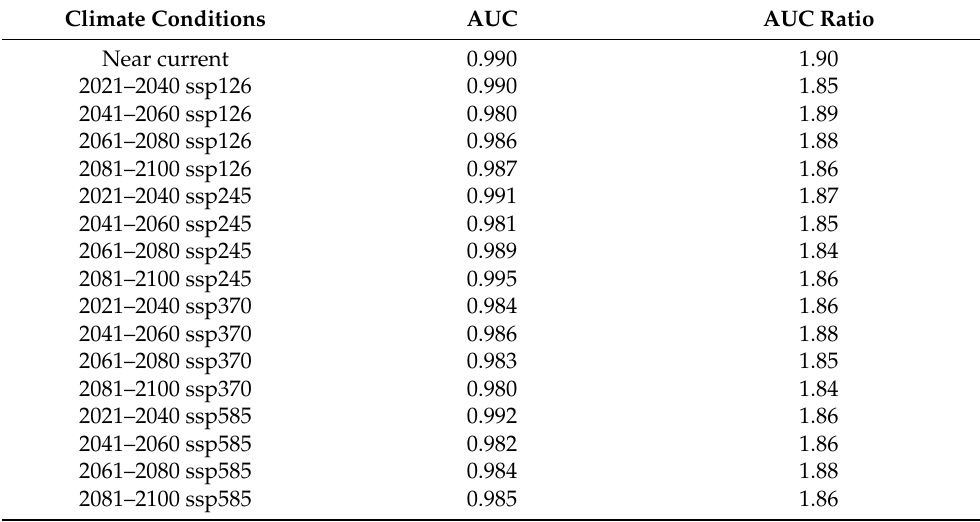
Table 2. The predictive accuracy of the maximum entropy model estimated by AUC and AUC